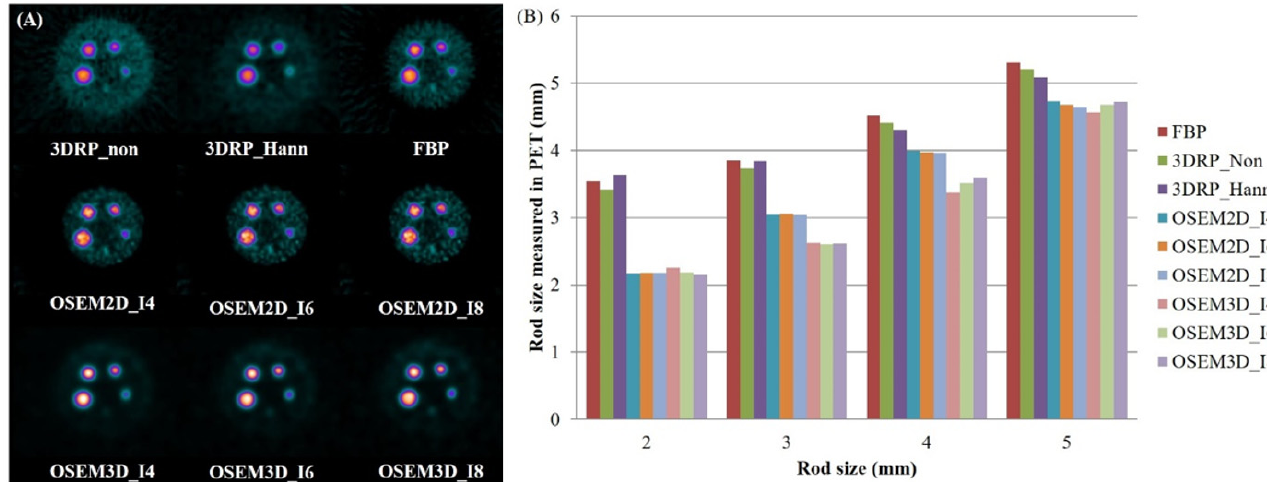
Figure 1. ( A ) Images of the hot rods in NEMA NU-4 were acquired via Inveon microPET. PET data were reconstructed using filtered back-projection (FBP), 2- and 3-dimensional ordered-subset expectation maximization (OSEM2D and OSEM3D, respectively), and 3-dimensional reprojection (3DRP). A Hann filter (projection filter) was used for the 3DRP reconstruction method only. In the OSEM reconstruction methods, iteration numbers were 4, 6, and 8. Image scale was fixed to the same scale. ( B ) The rod size was calculated via full width at half maximum in the NEMA NU-4 mouse image quality phantom. In the 2, 3, and 4 mm rods, the accuracy of OSEM2D reconstruction method was higher than that of the other methods.